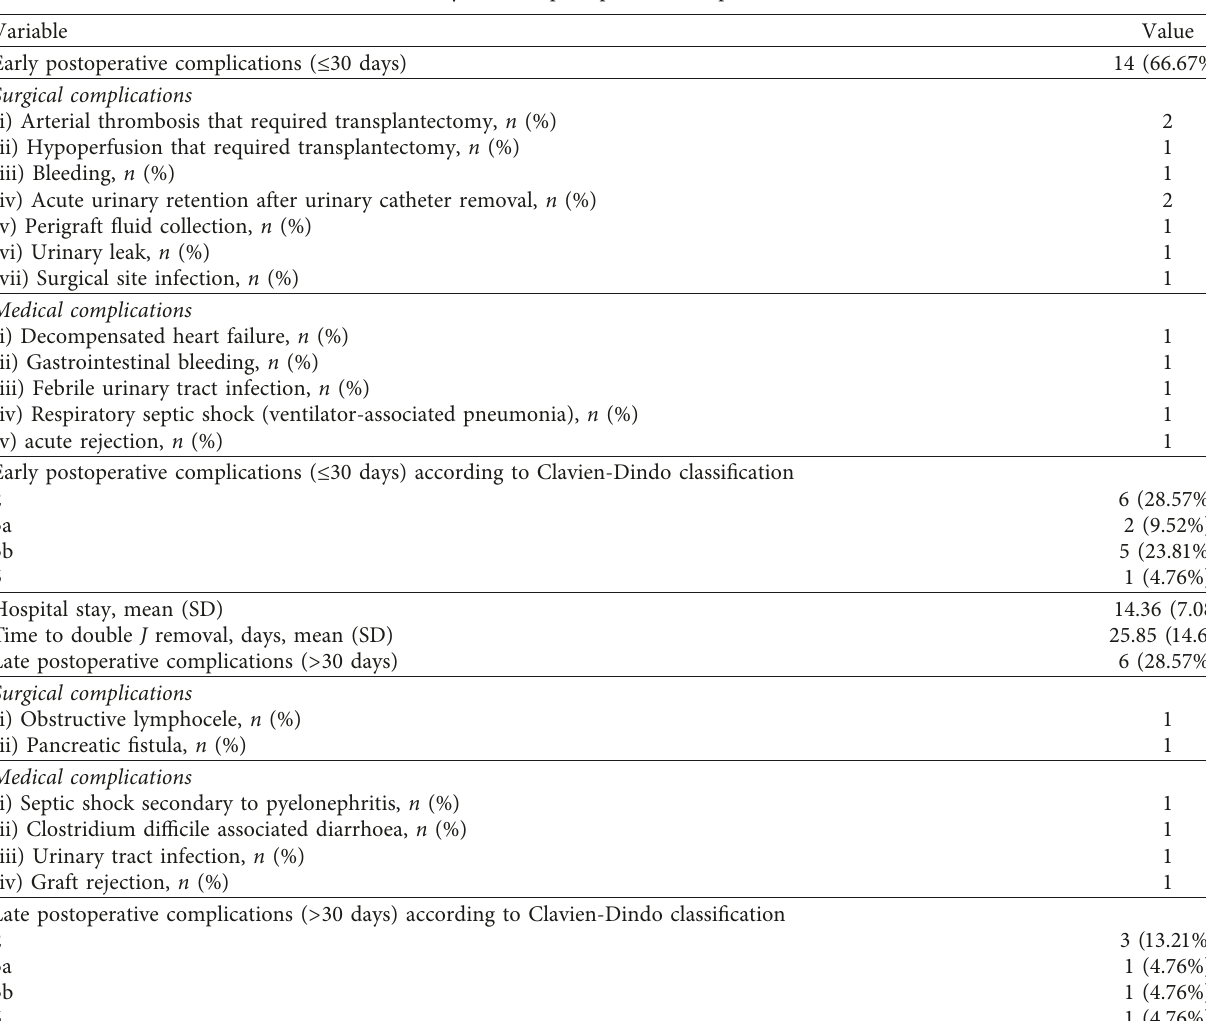
Table 4: Early and late postoperative complications of